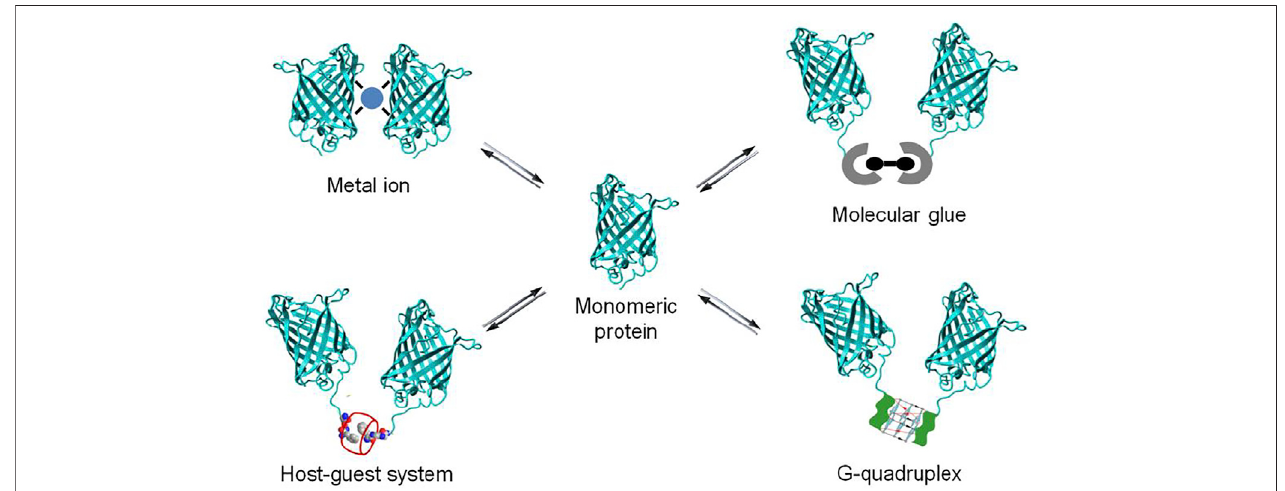
FIGURE 2 | Schematic representation of dimerization of protein via molecular